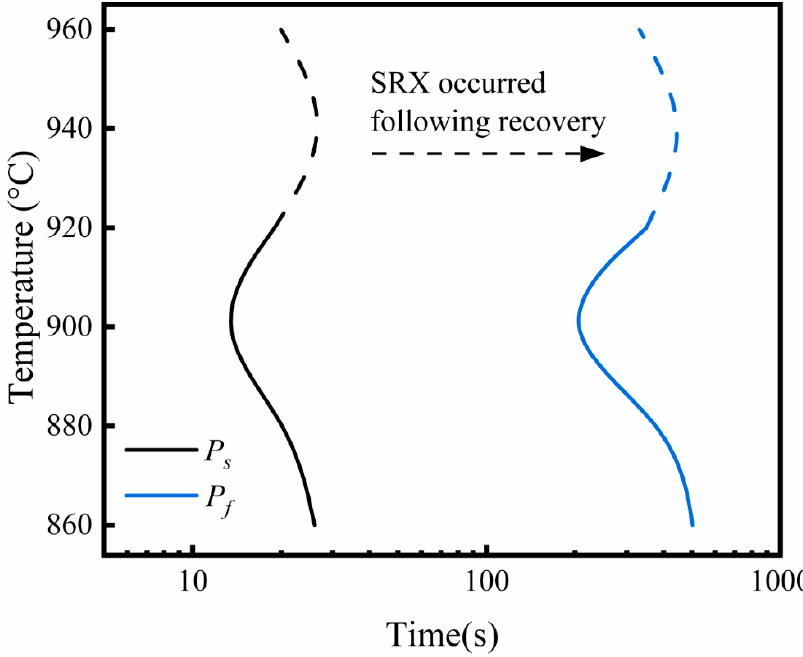
Figure 3. PTT curve for the Ti microalloyed steel .